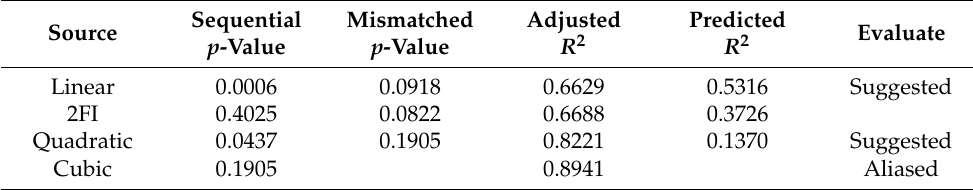
Table 7. Comprehensive analysis of various models of